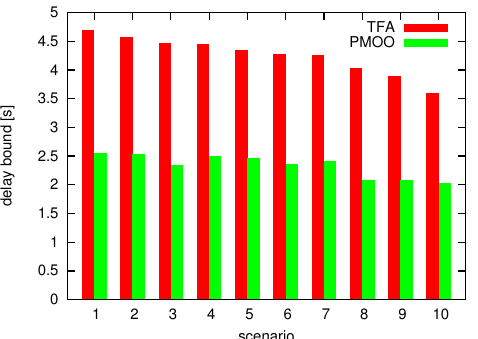
Figure 7. Baseline comparison between pay multiplexing only once (PMOO) and total flow analysis (TFA) for different scenarios.